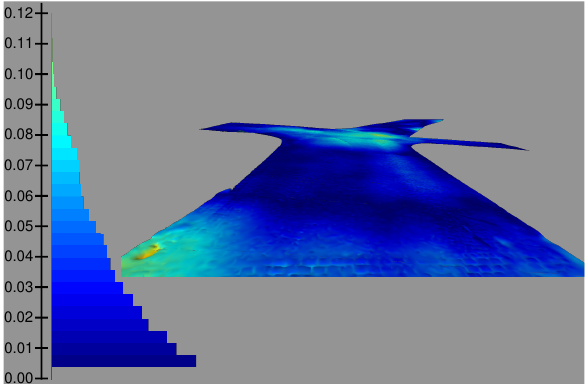
Figure 8. Deviations, obtained by Hausdorff metric given in meters, projected to the refined road surface at level 12 in comparison to the input road model